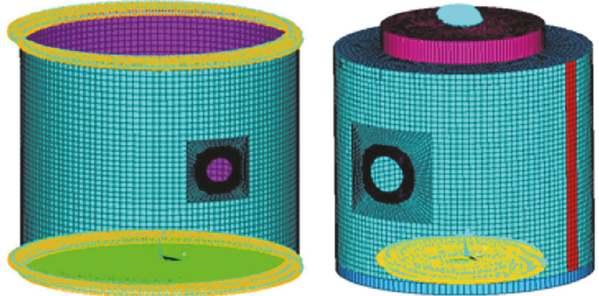
Figure 9: FEM models for CBC and RBC of a cylindrical shell with